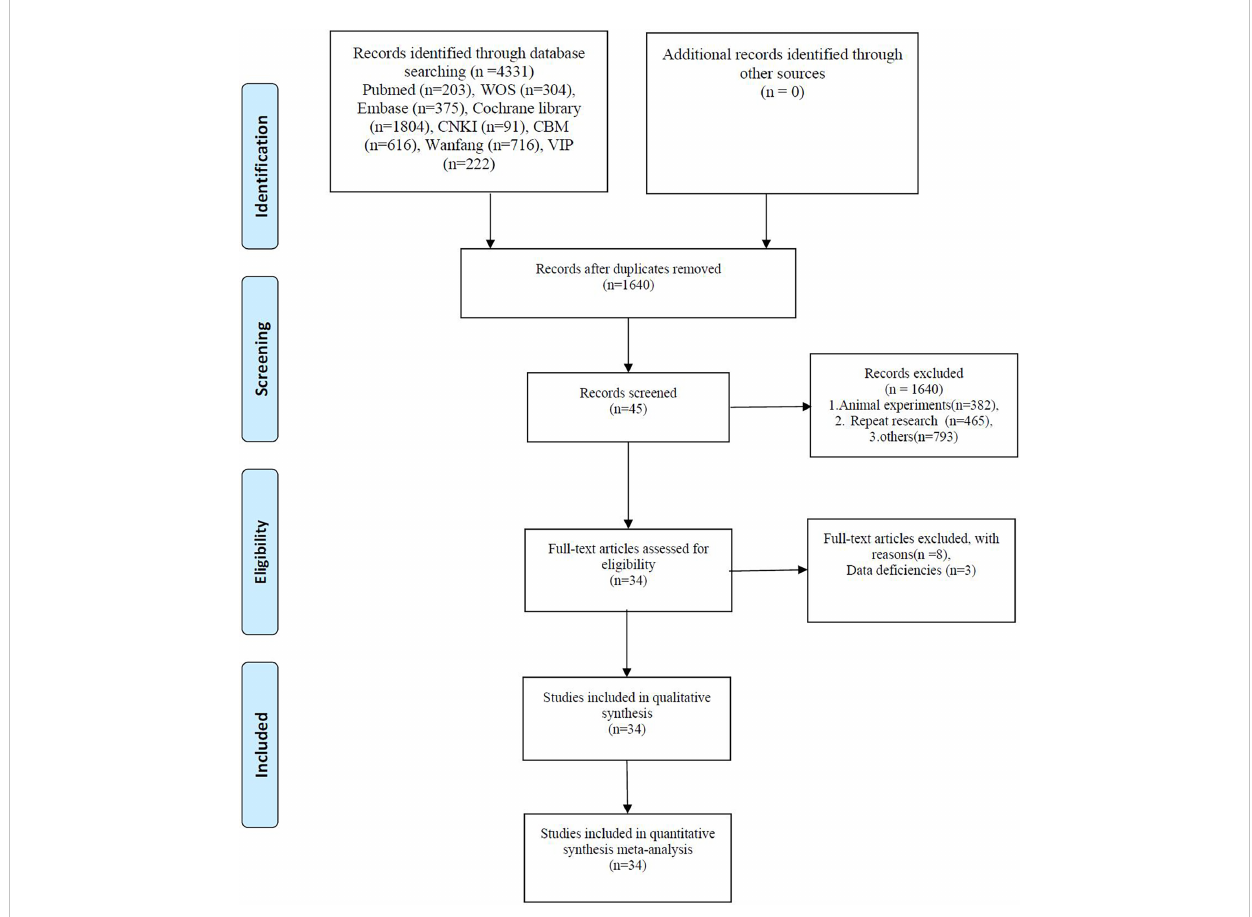
FIGURE 1 The PRISMA fl ow chart of selection